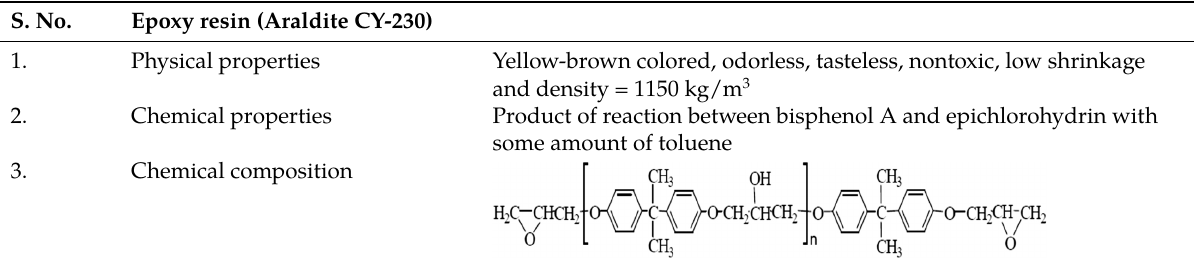
Table 5: Physical and chemical properties of the epoxy resin (CY-230). S.